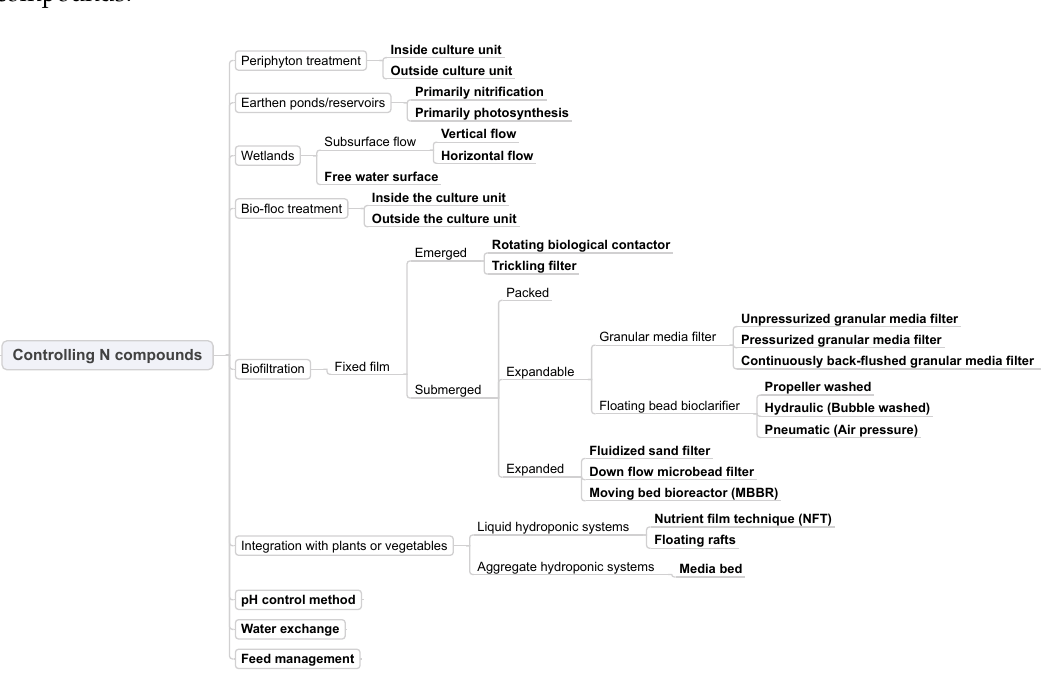
Figure 5. Taxonomy: controlling N